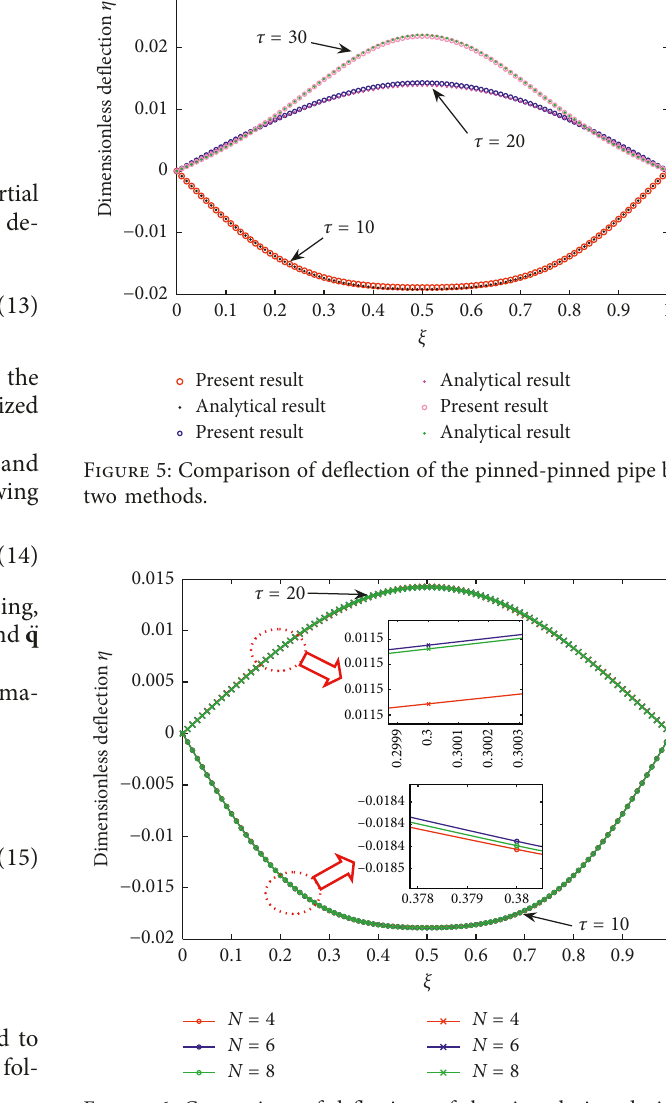
Figure 6: Comparison of deflections of the pinned-pinned pipe with different N .